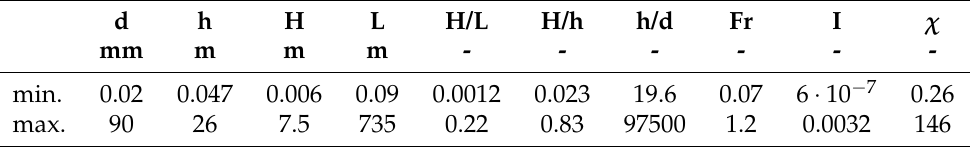
Table 5. The main characteristics of the comparative data (all data).